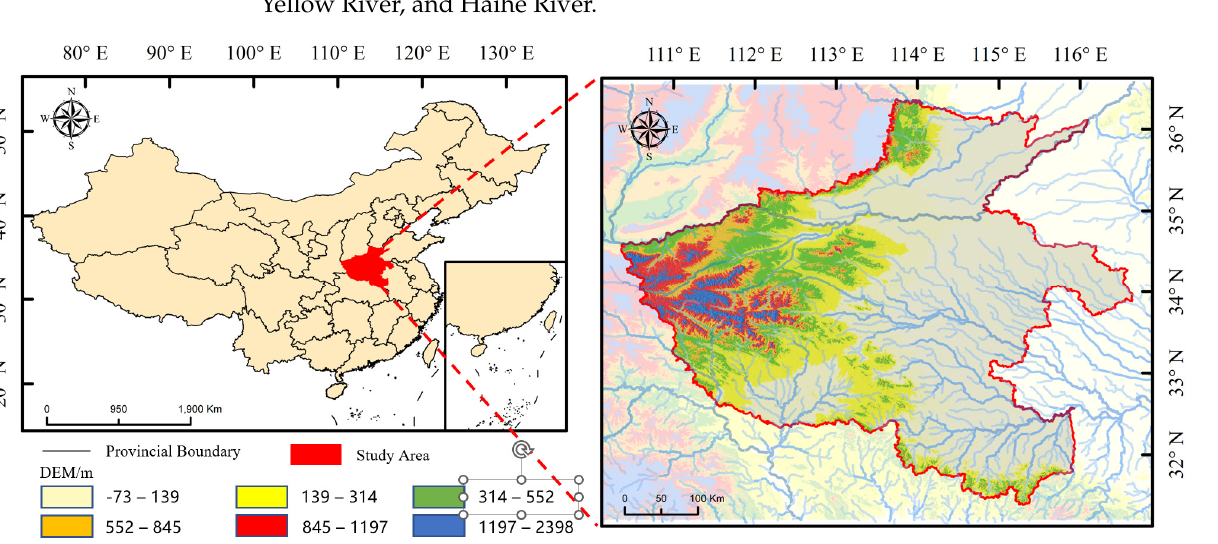
Figure 1. Schematic diagram of experimental area.